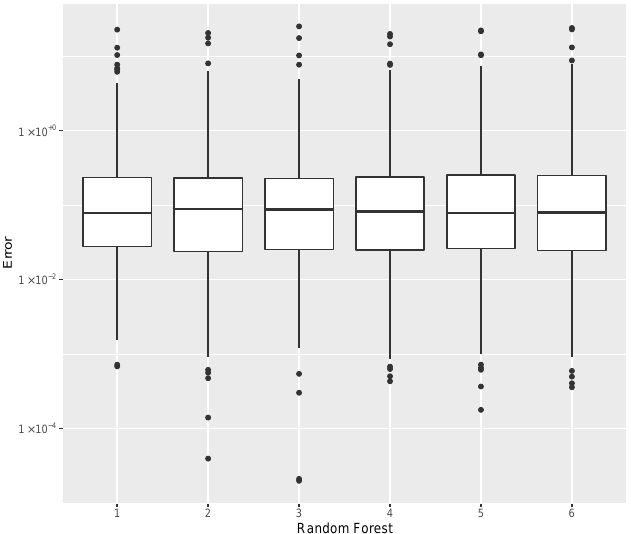
Figure 13. Error dispersion of the P critical estimate using distinct Random Forest parameters. Different values for trees and splits resulted in small performance deviations. A similar profile is observed in all the datasets considered. As a result, this method is seen as a robust choice for meta-modeling which does not require specific knowledge about parameter tuning in order to obtain good